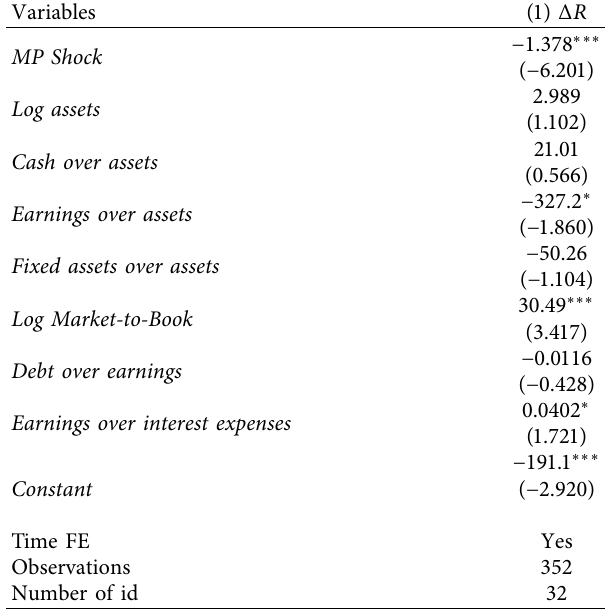
Table 5: Stock price effect of unexpected IEOMP on listed military and defense